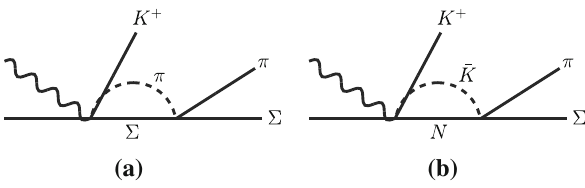
Fig. 15 Mechanisms considered in Refs.